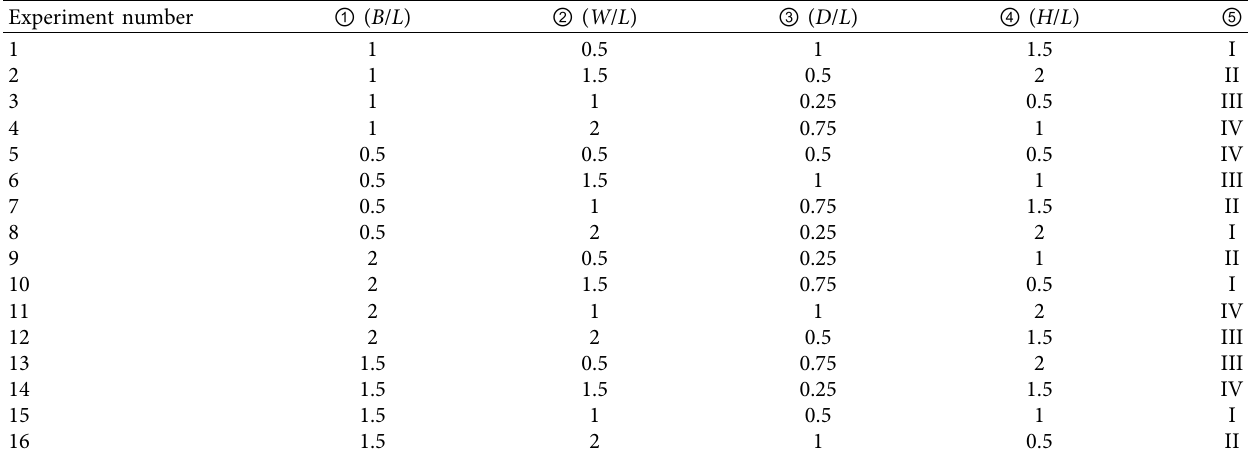
Table 5: The orthogonal experiment